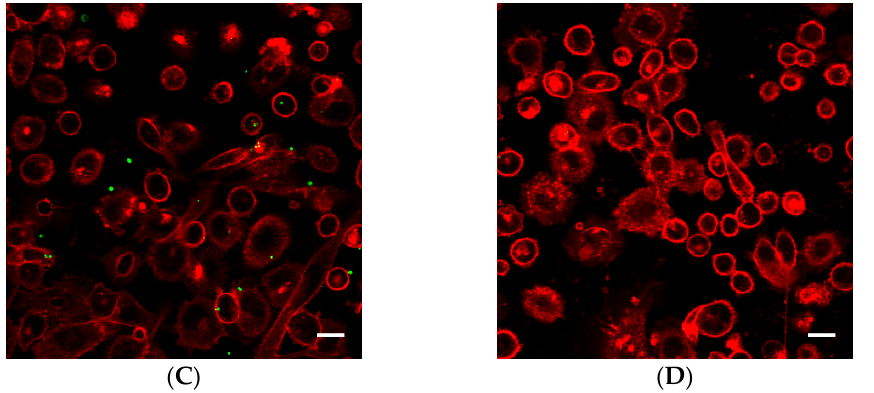
Figure 4. Representative overview confocal images of PC3 cells showing Cell Masks (red) and nanoparticles (green) both on the surface and inside the cells. In addition to the free nanoparticles, the cells were treated with ( A ) nanoparticle-loaded microbubbles but no ultrasound at 37 ◦ C (control), ( B ) nanoparticle-loaded microbubbles and ultrasound at 4 ◦ C, ( C ) nanoparticle-loaded microbubbles and ultrasound at 37 ◦ C or ( D ) Sonazoid and ultrasound at 37 ◦ C. The scale bars are 20 µm.